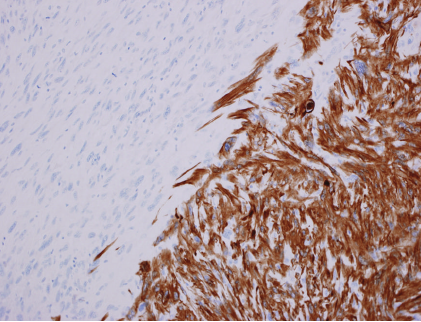
Figure 2: Macroscopic finding. The mass is separated from the testis and epididymis.